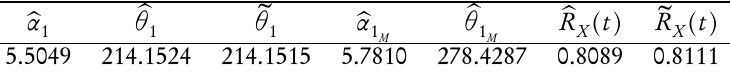
and θ of Weibull distribution and its 1 1 ( t ) for time t = 2 based on Data set I. X